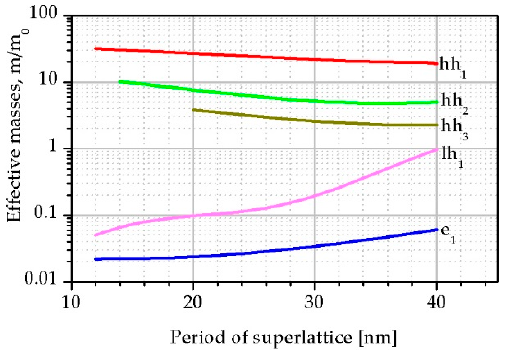
Figure 6. The calculated e 1 and hh 1 , hh 2 , hh 3 and lh 1 effective masses for the k z -direction of the Brillouin zone versus SL period.